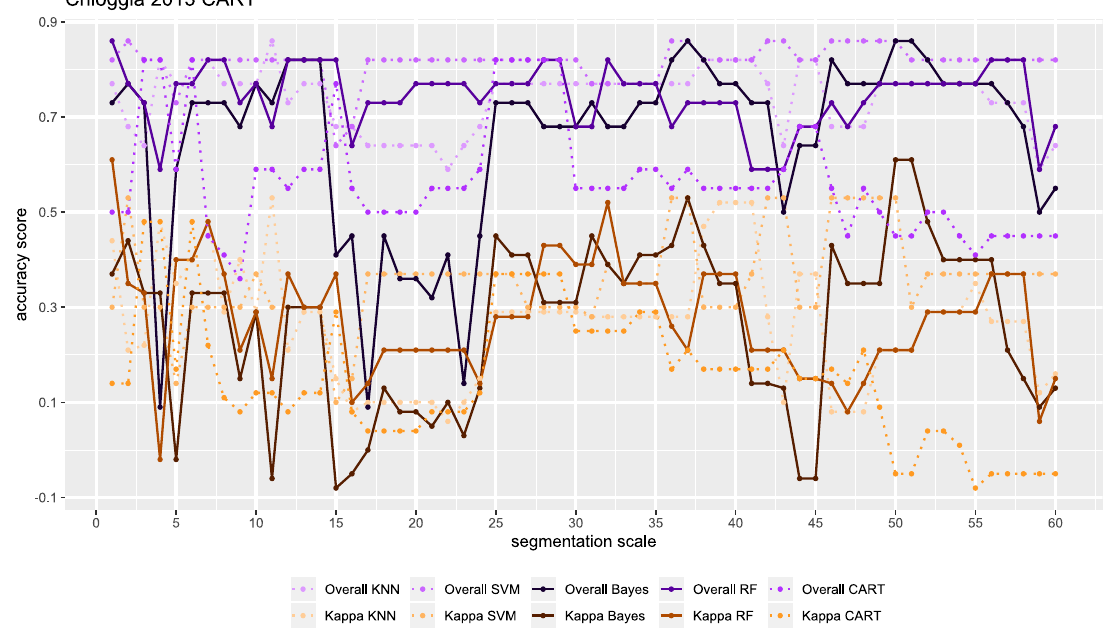
Figure A2. Overall and kappa accuracy assessment charts for scales of multiresolution segmentation 1–60. Chioggia 2013 dataset divided for four classes, CART feature-selection algorithm.